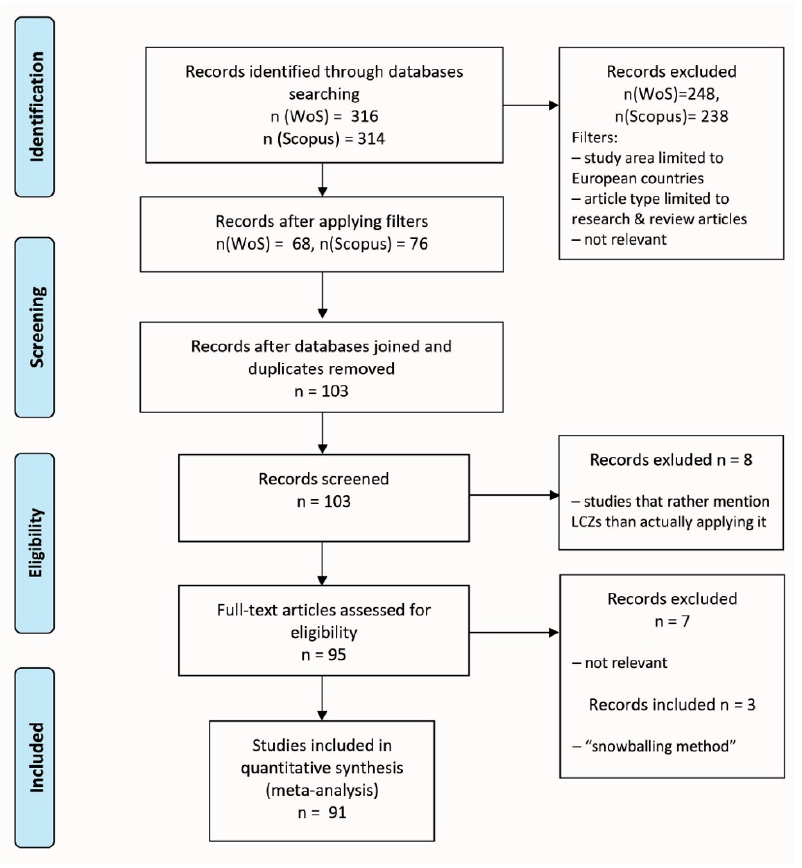
Figure 2. Flow-chart of the literature selection and review process using initial keywords and WoS/Scopus databases [56].